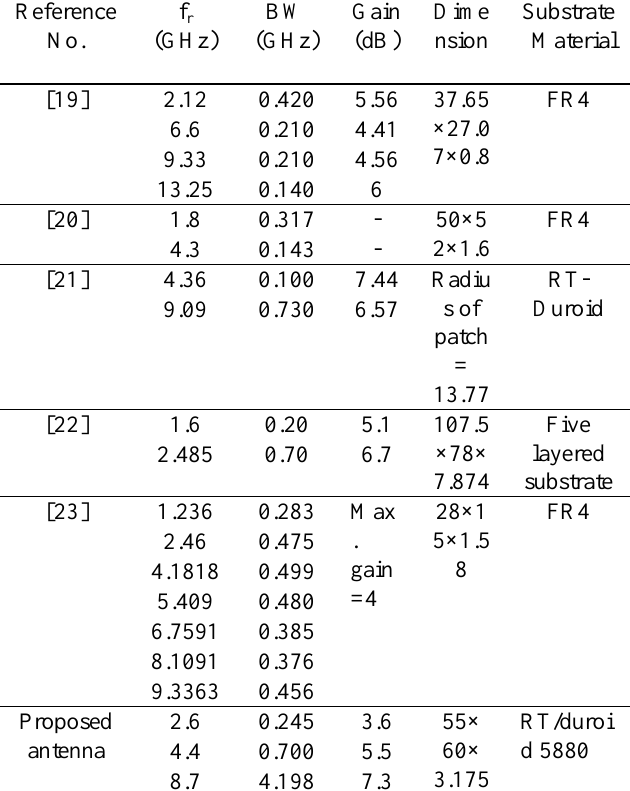
Figure 7: 3-D Polar plot of gain of proposed antenna (a) at 2.6 GHz (b) at 4.4 GHz (c) at 8.7 GHz Table 3. Comparison of the proposed antenna with existing